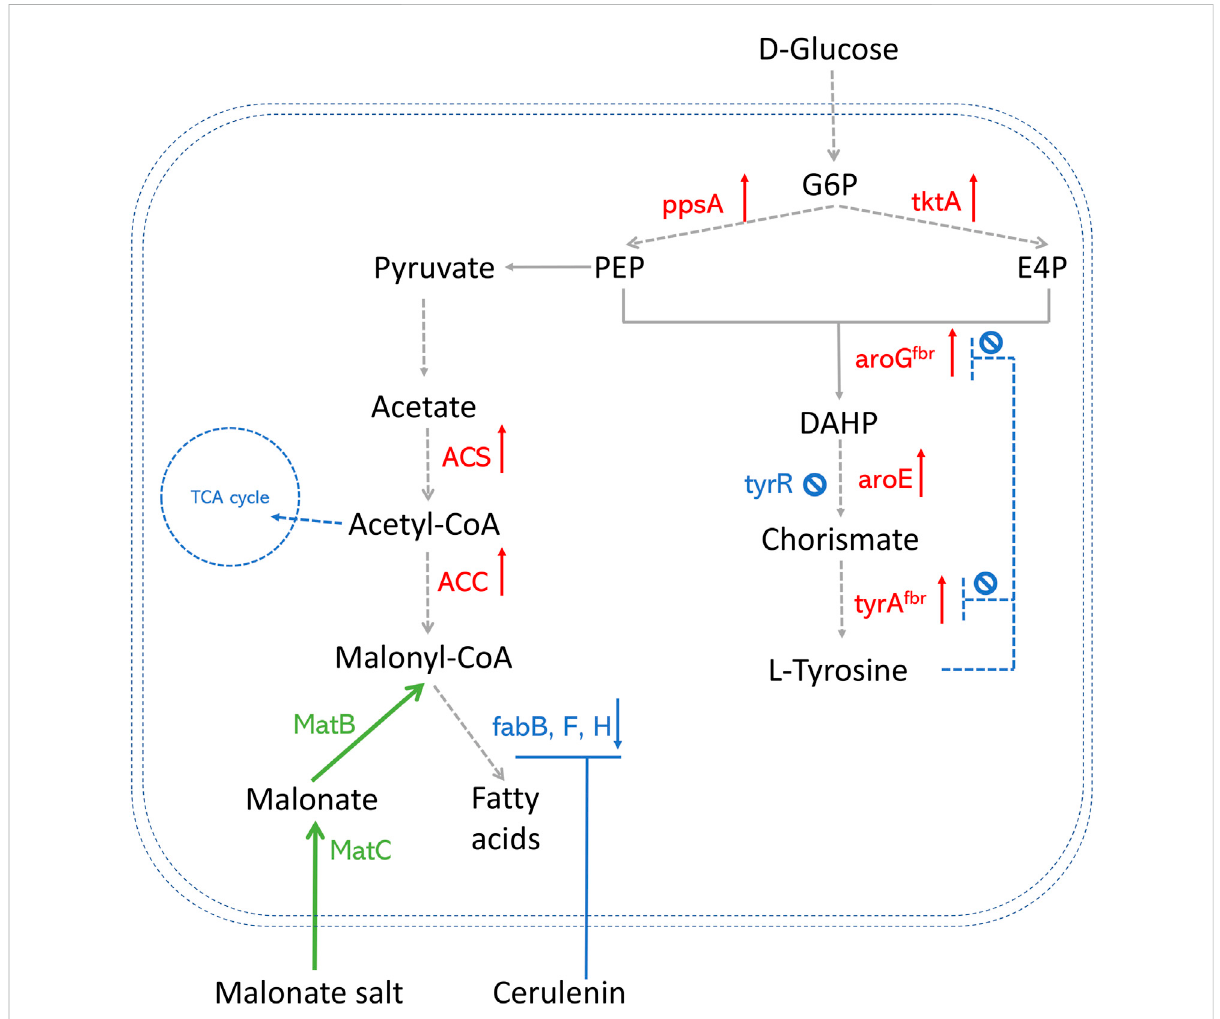
FIGURE 2 An overview of precursor enhancement engineering in E. coli . Genes and enzymes in red are overexpressed. Genes and enzymes in blue are deleted or downregulated. Genes and enzymes in green are heterologous expressed. Dotted arrows refer to multiple steps. G6P, glucose-6- phosphate; PEP, phosphoenolpyruvate; E4P, erythrose-4-phosphate; DAHP, 3-deoxy-D-arabino-2-heptulosonic acid 7-phosphate; fabH, gene that encodes 3-oxoacyl carrier protein synthase III; fabB/fabF, genes that encode the beta-ketoacyl-acp synthase I/II protein; MatB, malonylCoA synthetase; MatC, malonate carrier protein; ACS, acetyl-CoA synthase; ACC, acetyl-CoA carboxylase; TCA cycle, tricarboxylic acid cycle; ppsA, phosphoenolpyruvate synthase; tktA, transketolase; tyrAfbr, chorismate mutase-prephenate dehydrogenase feedback